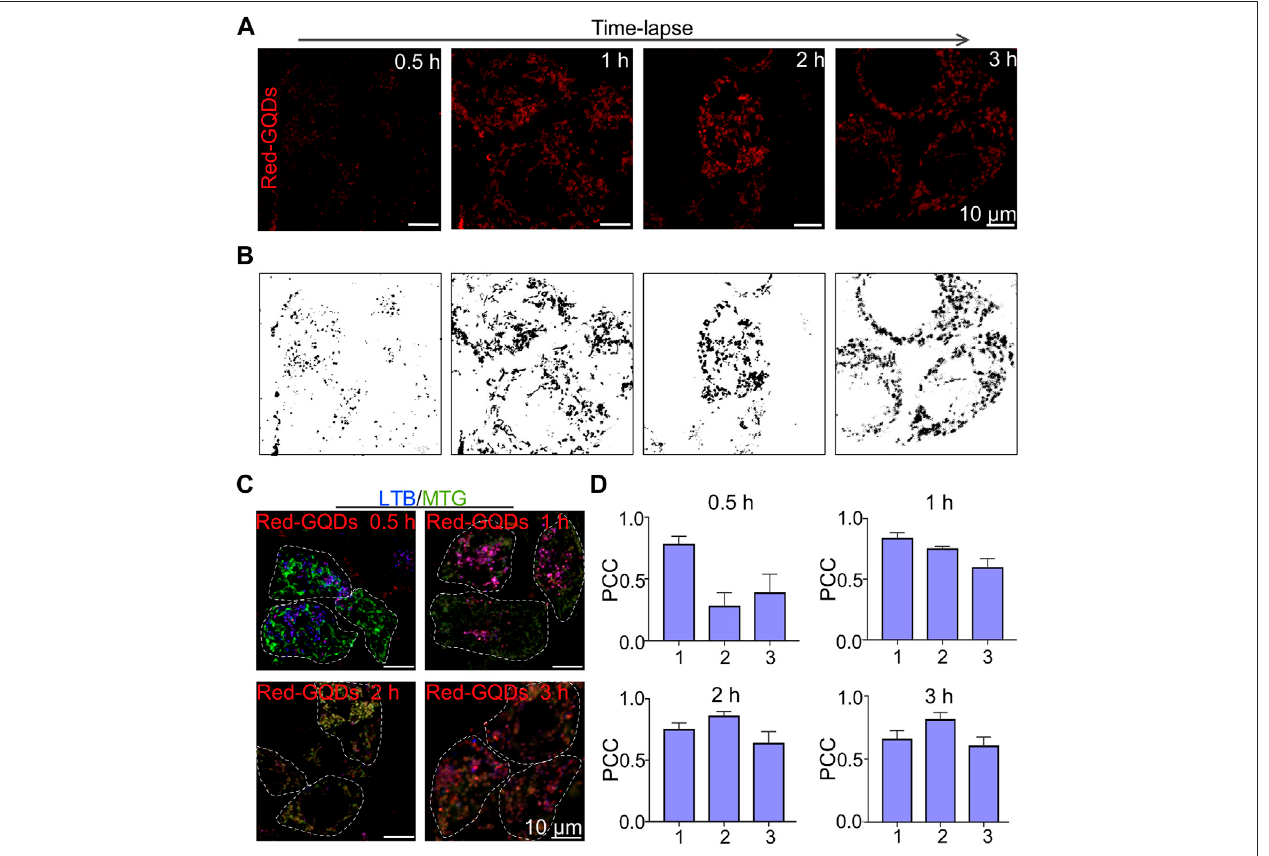
FIGURE2| VisualizationofRed-GQDsdescriptioninlivingcells. (A,B) FluorescenceimagesandgrayscaleimagesofHeLacellsincubatedwithRed-GQDs(25 μ g/ ml) for 0.5, 1, 2, and 3 h (C) HeLa cells were co-stained with Red-GQDs (10 μ g/ml, 1 h) and LTB and MTG commercial probes. LTB: λ ex = 405 nm and MTG: λ ex = 488 nm. (D) PCC value in various groups. 1: Red-GQDs and LTB; 2: Red-GQDs and MTG; 3: LTB and MTG. Data are presented as mean ± SEM ( n = 4).